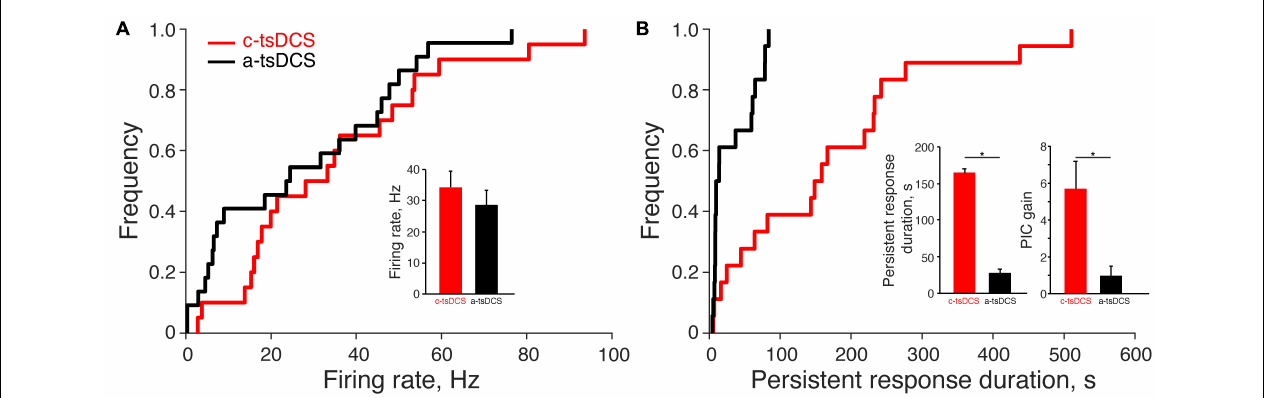
FIGURE 3 | Effect of trans-spinal direct current stimulation (tsDCS) on the motor unit direct and persistent response. (A) The cumulative distribution functions of the direct response for anodal-tsDCS (a-tsDCS) and cathodal-tsDCS (c-tsDCS) were not significantly different (K-S test, p = 0.22). Inset plots mean firing rates during both c-tsDCS and a-tsDCS, which were not significantly different ( t -test, p = 0.29). (B) The cumulative distribution function of persistent response duration was significantly different between c-tsDCS and a-tsDCS (K-S test, * p = 0.0005). The inset plots mean PIC duration, which was significantly longer for c-tsDCS ( t -test, * p = 0.0002) and PIC gain, was significantly longer and stronger during c-tsDCS than during a-tsDCS ( t -test, * p = 0.006).